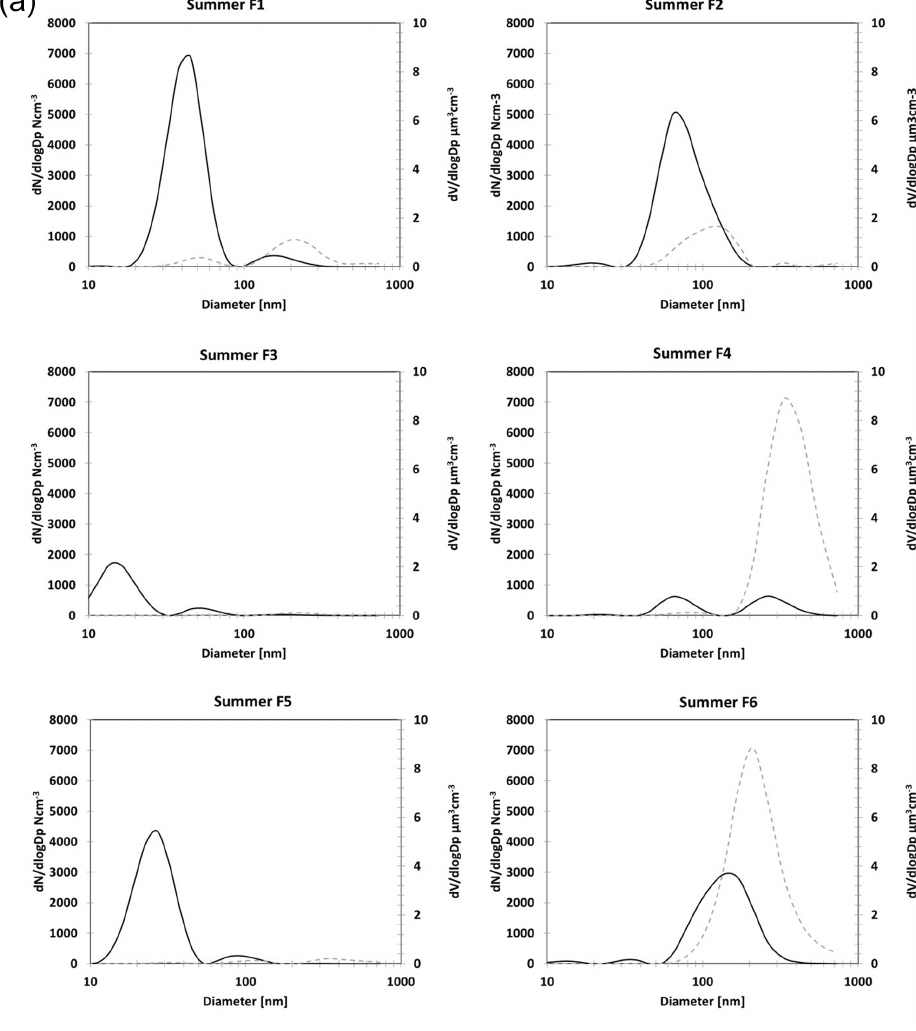
Atmos. Chem. Phys., 22, 5829–5858, 2022